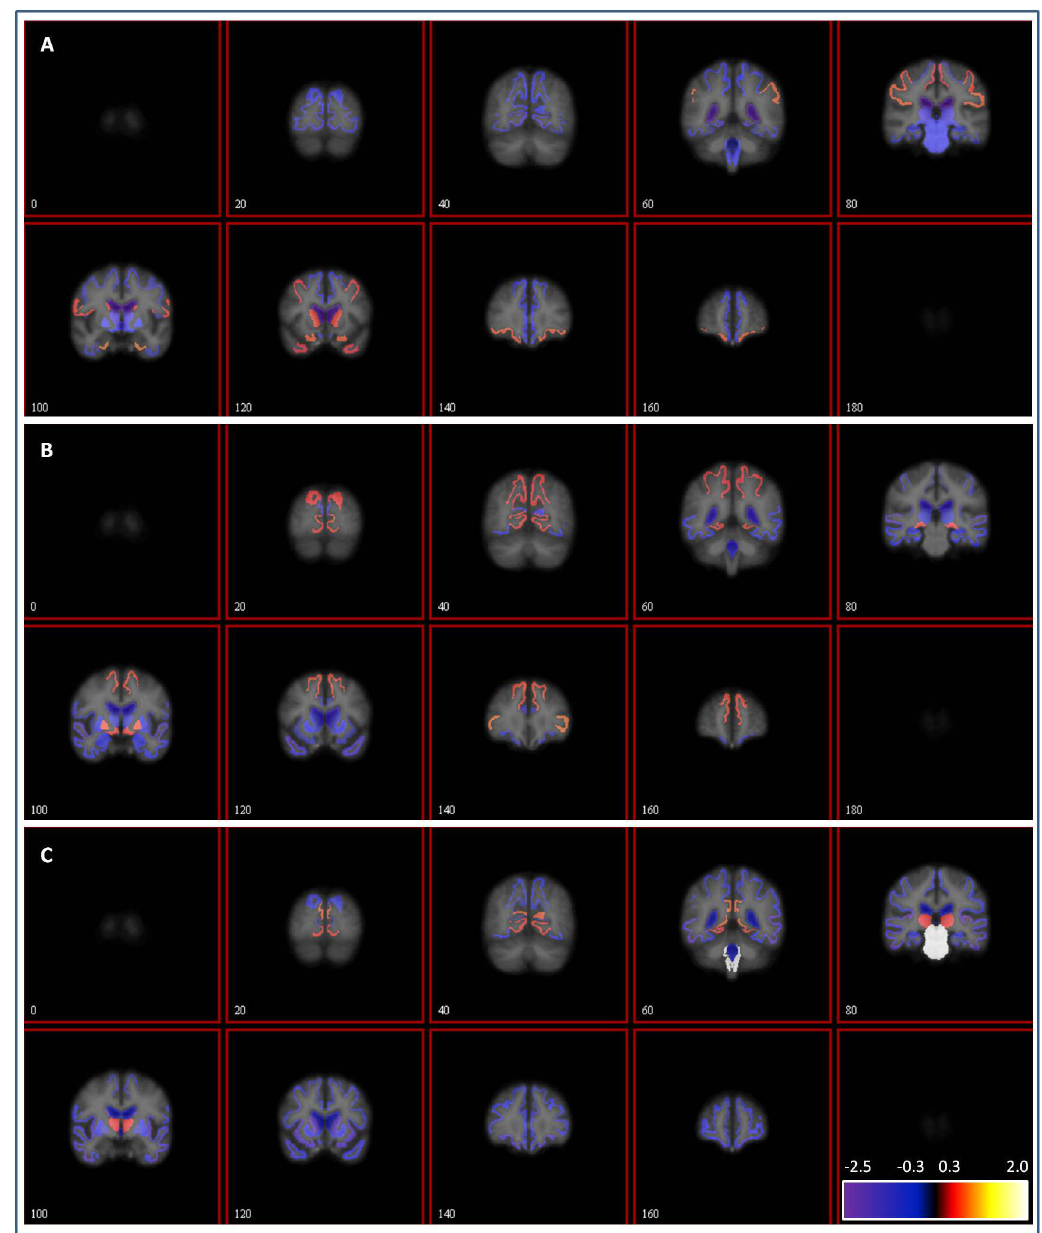
Figure 3. Exploratory analysis of longitudinal volume changes in relation to baseline CSF α-synuclein. Results from an exploratory analysis of effects of CSF α-synuclein on volume change in all available regions. Statistics for FreeSurfer regions were plotted on a T1 brain image template. Colors indicate regional t-values for the interaction CSF α-synuclein:time in linear mixed effects models, adjusted for APOE, sex and age, in NL (panel A), MCI (panel B), and AD (panel C). Increasingly positive t-values are indicated by red-yellow-white colors and increasingly negative t-values by blue-purple colors. Regions with T-values > -0.30 and < 0.30 (roughly corresponding to P-values > 0.75) are not colored (see scale). Note that the sign of the t-value depends on the relationship between CSF α-synuclein and volume change. Thus, in regions with negative volume change (atrophy), a negative t- value indicates that higher atrophy rates were seen in subjects with high CSF α-synuclein, and a positive t-value that higher atrophy rates were seen in subjects with low CSF α-synuclein. In contrast, in the few regions where the longitudinal volume change was positive (ventricles and pallidum in NL, MCI and AD, and pericalcarine in MCI), a negative t-value indicates that volume enlargement was seen in subjects with low CSF α-synuclein, and a positive t-value that volume enlargement was seen in subjects with high CSF α-synuclein. No effect was significant when correcting for multiple comparisons (correcting within study group [48 tests]).